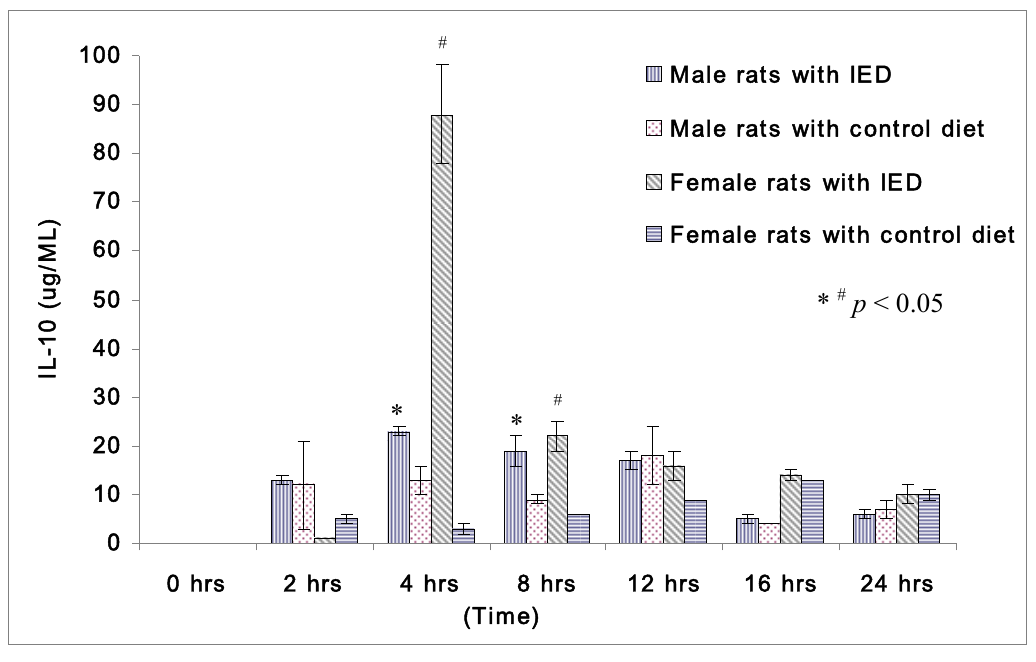
Figure 3. Plasma concentrations of IL-10 ( μ g/mL) in rats at 0, 2, 4, 8, 12, 16, and 24 h after CLP in cirrhotic female rats fed with control diet ( n = 28), cirrhotic female rats fed with immune enhancing diet ( n = 28), cirrhotic male rats fed with control diet ( n = 23), and cirrhotic male rats fed with immune enhancing diet ( n = 23). * p < 0.05 between male rats; # p < 0.05 between female rats; IL-10, interleukin-10. The data are expressed as Mean ±